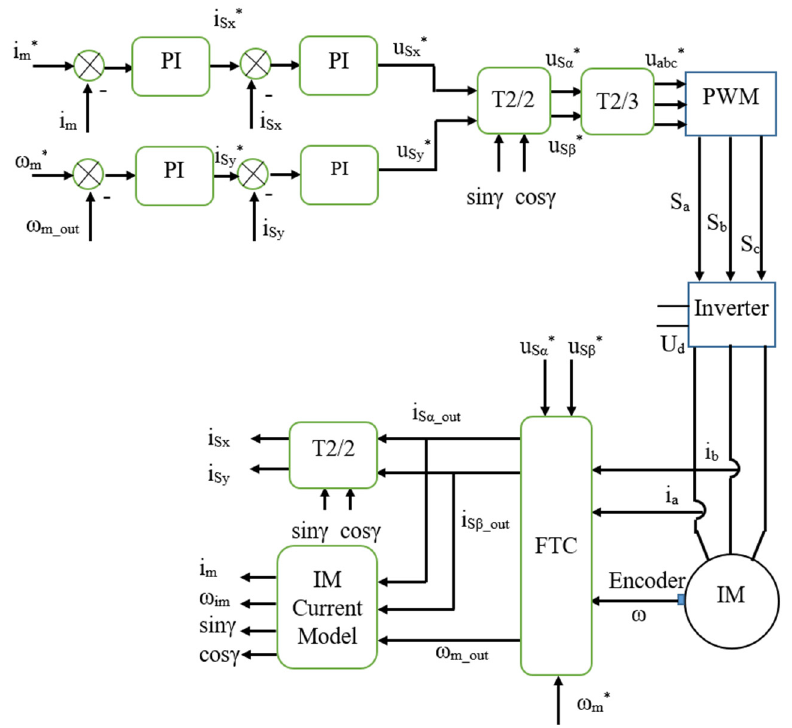
Figure 3. Block diagram of FOC-based IMD using FTC functions (the symbol * means reference values).